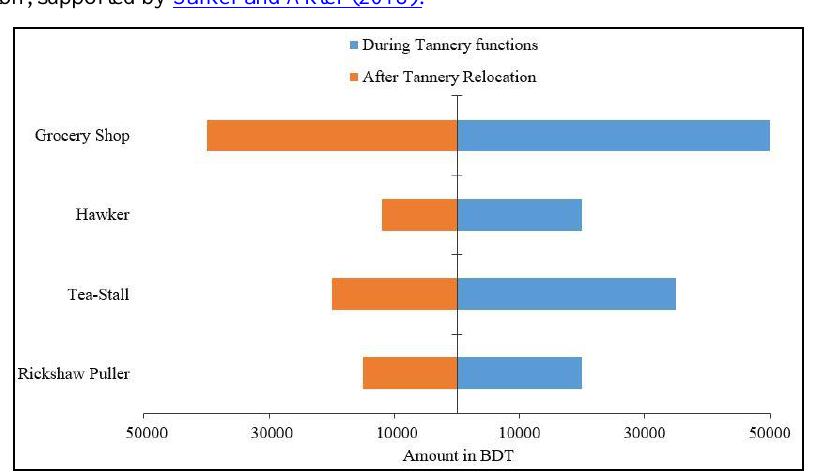
Figure 7: Change in Local Economy and Business